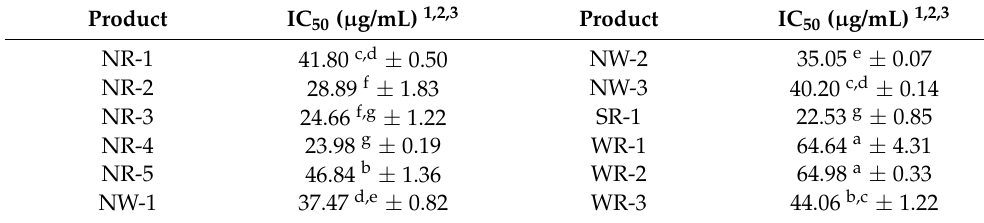
Table 4. DPPH antioxidant activity of extracts from Z. officinale rhizomes.